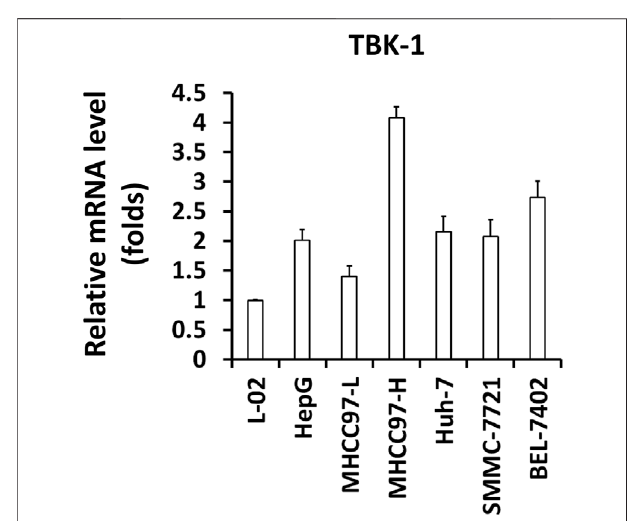
FIGURE 2 | The expression level of TBK1 in hepatic cell lines. The expression level of TBK1 in hepatic cell lines was examined by qPCR. The results were shown as Histogram form mean ±